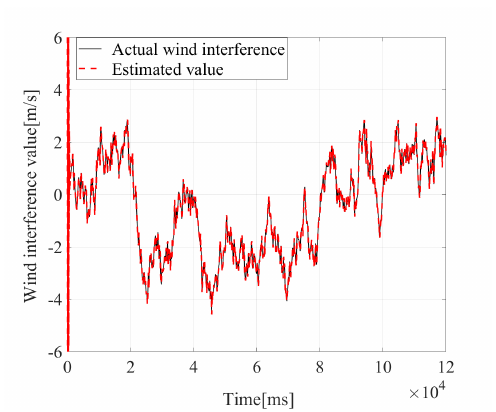
Fig. 10. Wind disturbance estimation in the pitch angle control channel.